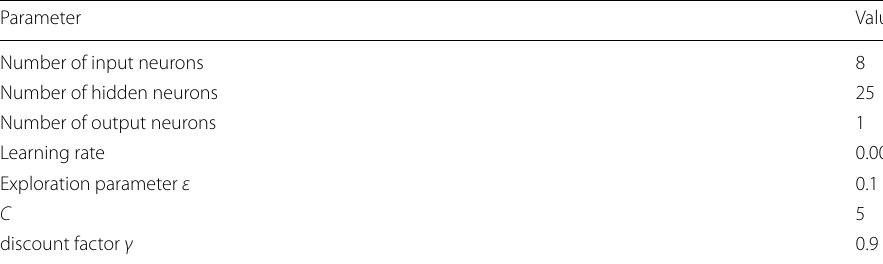
Table 2 Algorithm